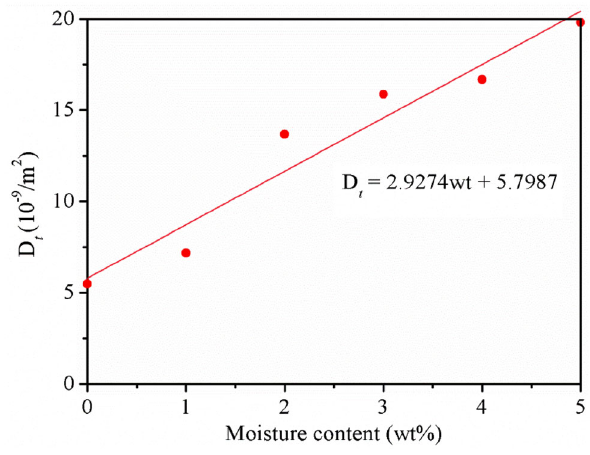
Fig. 7 The CH 4 transport diffusion coefficients as a function of water content